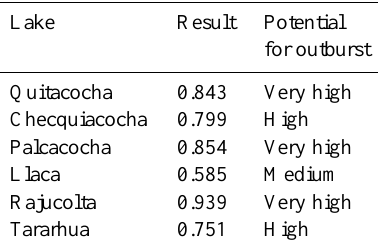
Table 11. The results of the quantitative method defined by Wang et al. (2011). Lake